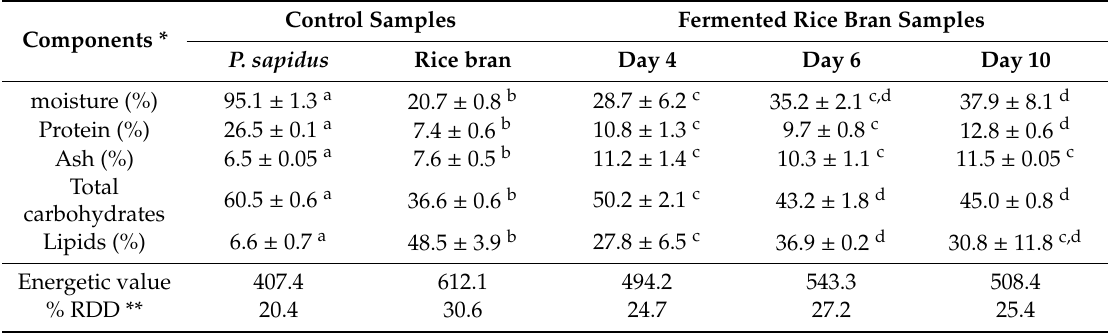
Table 1. Nutritional composition of P. sapidus , rice bran (unfermented), and fermented rice bran at di ff erent cultivation times (4, 6, and 10